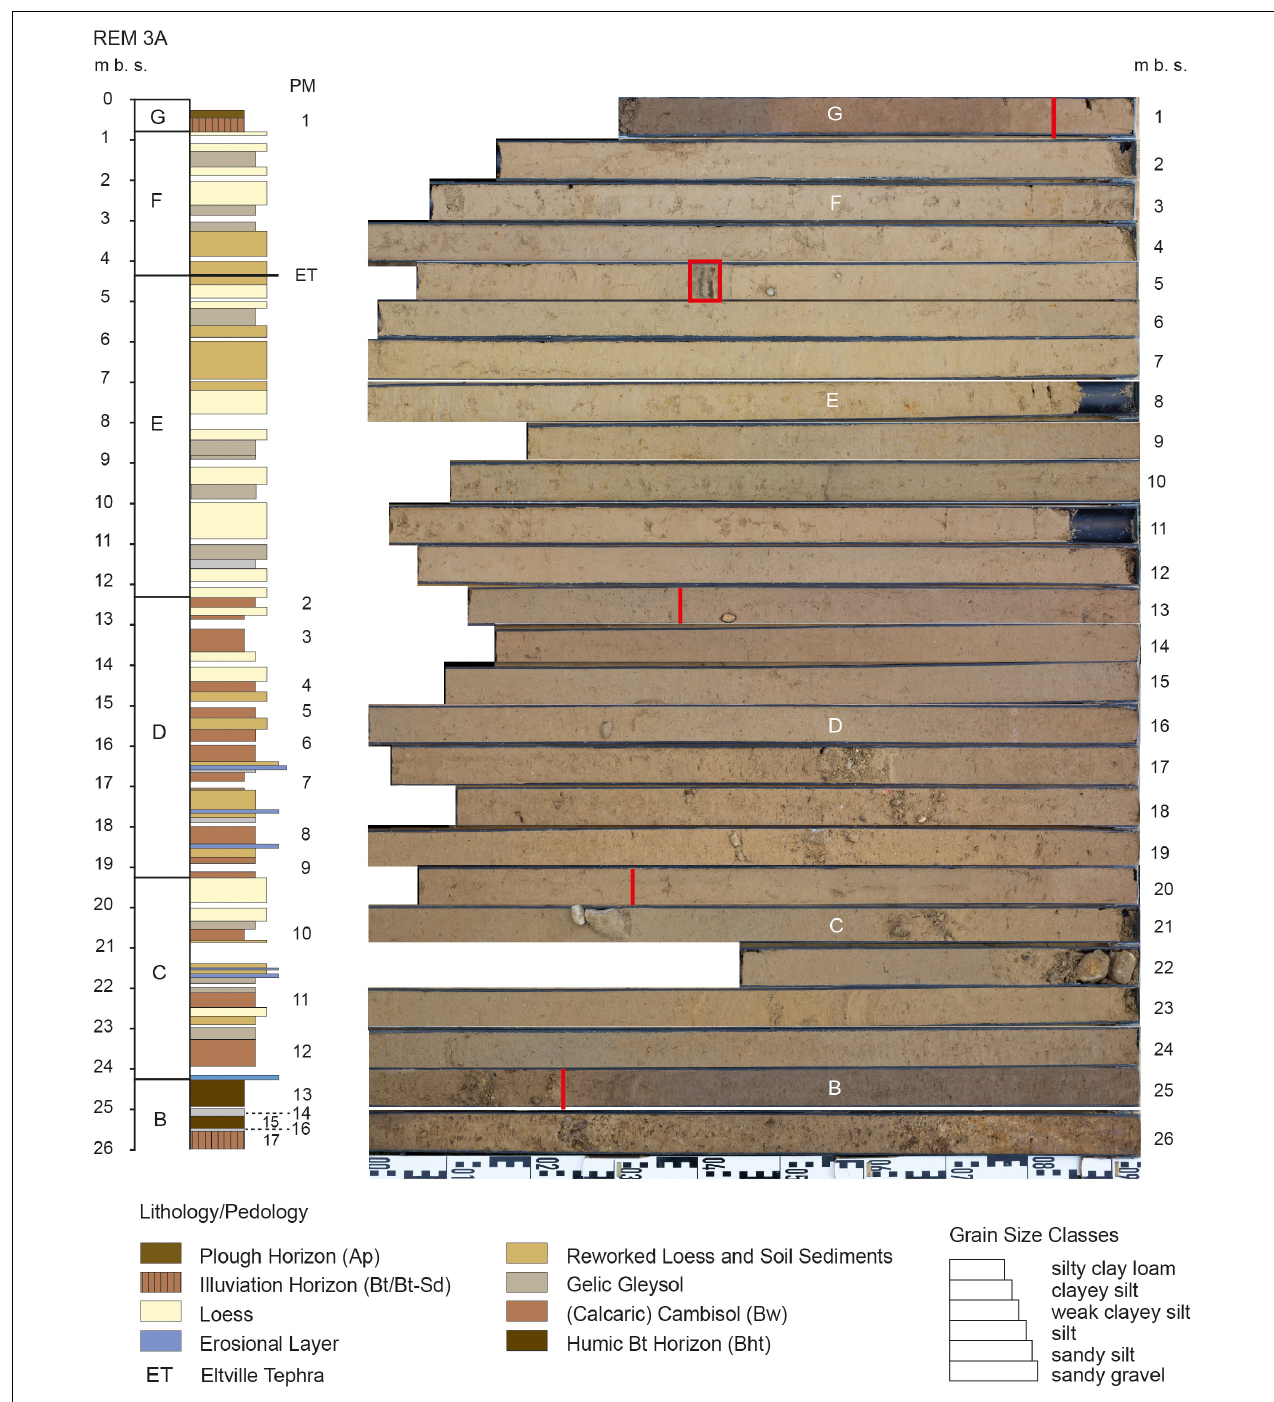
FIGURE 3 | Litho- and pedostratigraphy and photo of core REM 3A. Units B–G (indicated by red bars and white text in the photo) are described in the text (note that unit A as well as the lowermost part of unit B are not part of the core REM 3A, but REM 3B). The underlying Lower Middle Terrace of the penultimate glaciation (Boenigk and Frechen, 2006) constrains the LPS formation to the Last Glacial Cycle (terrace sediments where detected in core REM 3B, not depicted here). Soil horizons apart from Gelic Gleysols are defined as pedogenic members numbered from bottom to top (PM 1–17). Soil classification followed the IUSS Working Group WRB (2015). However, Sew and Sd horizons are based on German classification. Estimated age of the Eltville-Tephra according to Zens et al. (2017) and Förster et al. (2020).